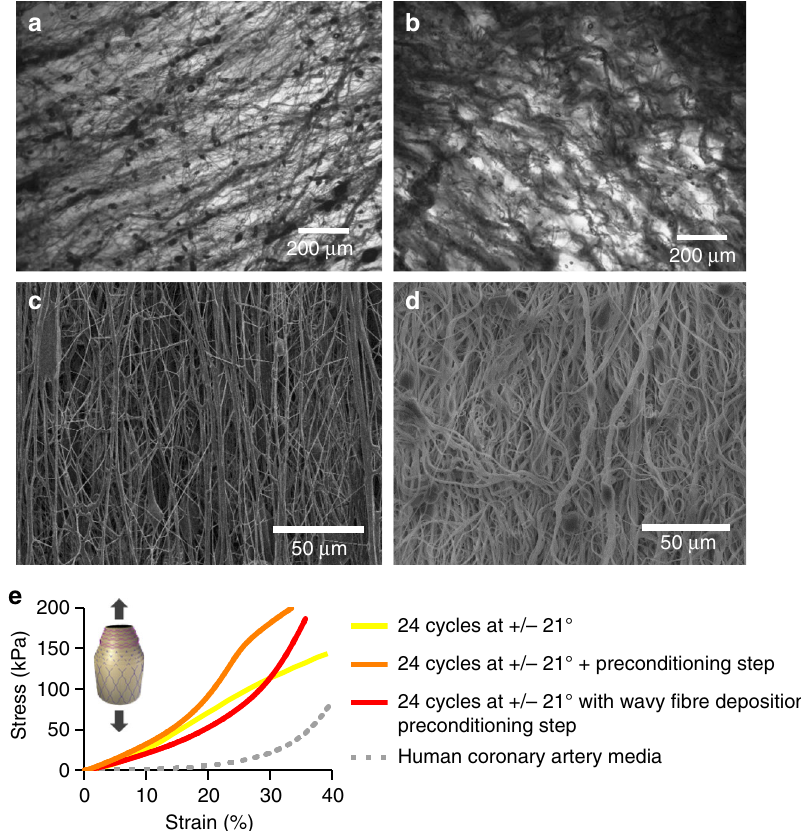
Fig. 4 Towards a J-shaped stress – strain curve combining wavy fi bre deposition and preconditioning: a Optical microscope image of a poly( ε - caprolactone) (PCL) fi bre sublayer fabricated at a deposition angle of 21° after one cycle of fi bre deposition with continuous clockwise rod spinning. b Optical microscope image of a PCL fi bre sublayer fabricated at a deposition angle of 21° after one cycle of fi bre deposition with alternated rod spinning and after the preconditioning step. c Scanning electron microscopy (SEM) image of a series of 24 PCL fi bre sublayers fabricated at a deposition angle of + / − 67°. d SEM image of a series of 24 PCL fi bre sublayers fabricated at a deposition angle of + / − 67° with alternated rod spinning and after the preconditioning step. e Longitudinal stress – strain curve for a series of 24 PCL fi bre sublayers fabricated with deposition angles of + / − 21°, with and without a stretch preconditioning step of fi ve cycles of loading/unloading at 30% strain and wavy fi bre deposition using the alternating rod spinning during angled fi bre deposition. The grey line represents previously published stress – strain mechanical behaviour of the media layer of the human coronary artery under longitudinal tensile testing 11 . One independent experiment was conducted for each plotted as a function of numbers of middle and outer sublayers (Fig. 5a). The outer graft layer fabricated with fi ve outer graft sublayers containing fi bres at + / − 67° exhibits a stress – strain curve resembling the adventitia layer, whereas the middle graft layer fabricated with four middle graft sublayers and fi bres at + / − 21° resembles the media layer (Fig. 5a). The middle and outer graft layers had a thicknesses of 323 ± 41 and 298 ± 42 µm, respectively, which together produces a wall thickness similar to the human coronary arteries (750 ± 170 µm) 33 .